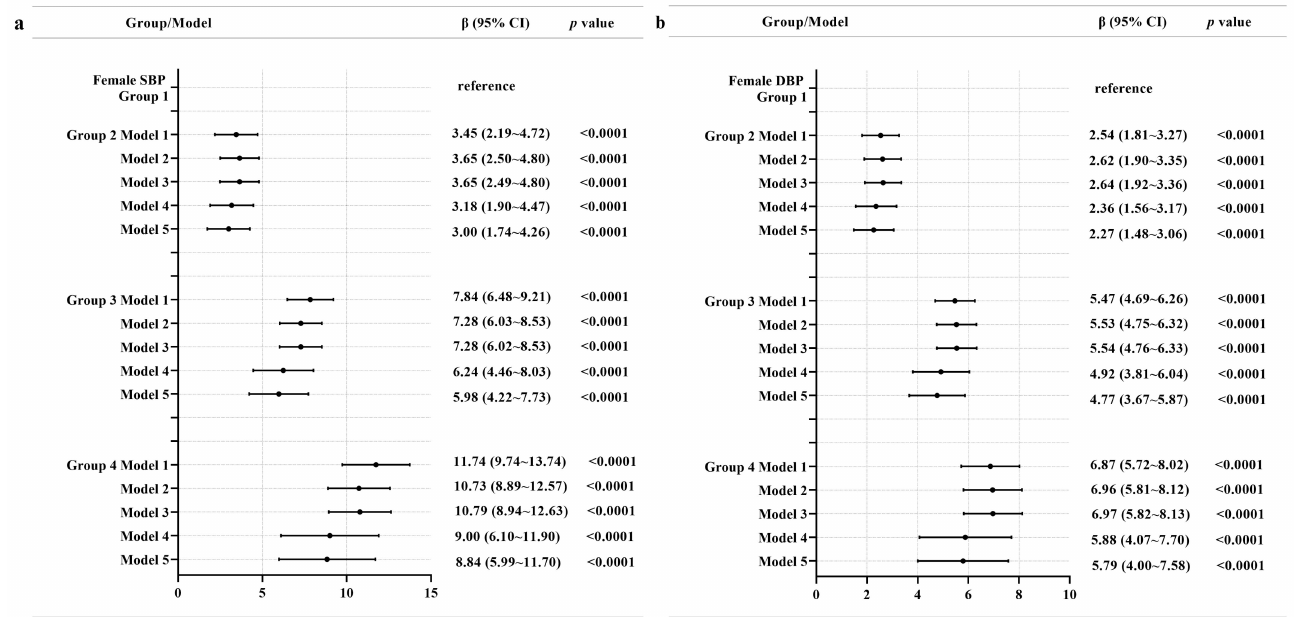
Figure 4. Associations between multiple trajectories and SBP ( a ) and DBP ( b ) in females. Note: Model 1 adjusted for no covariates. Model 2 adjusted for age, education level, geographic region (urban or rural), annual per capita household income, survey year, and follow-up time. Model 3 additionally adjusted for physical activity, current smoking status, current alcohol drinking status, Na intake, and K intake. Model 4 additionally adjusted for BMI and WC at baseline. Model 5 additionally adjusted for SBP and DBP at